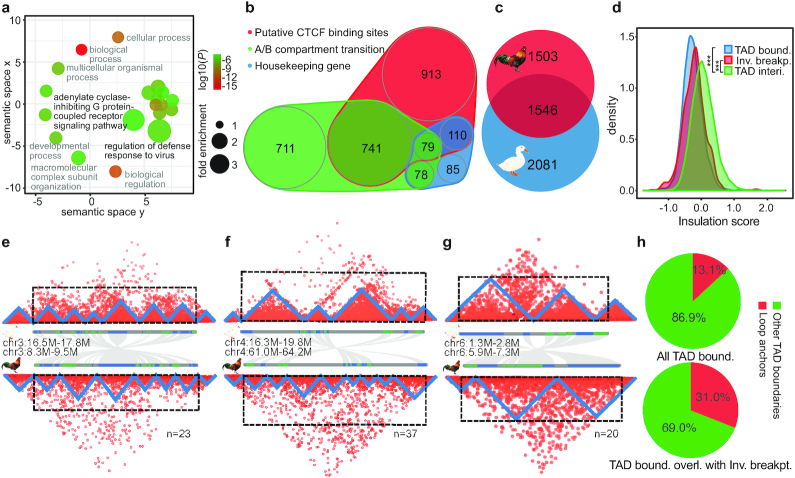
Genome inversions and topologically associated domains. a, Enriched GO terms of the genes included in the duck-specific inversions. The x- and y-axes measure the GO term semantic similarities, which are used to remove the GO redundancies. b, Scaled Venn diagram shows the different compositions of TAD boundaries in duck. c, Scaled Venn diagram shows the TAD boundaries shared between chicken and duck. d, Inversion breakpoint regions tend to show a significantly lower insulation score than the TAD interior regions. e–g, Hi-C heat maps, with each triangle structure indicating 1 TAD, along with the gene (blue or green bars) synteny plot between chicken and duck. Three examples are presented to show the impact of inversions between duck and chicken on TAD structure, with both inversion breakpoints (e), 1 inversion breakpoint (f), and no breakpoint (g), overlapped with the TAD boundaries. We also show the numbers of inversions that fit into each category. h, Pie charts showing that TAD boundaries that overlap with inversion breakpoints (bottom) have a higher percentage of loop anchors than others (top).